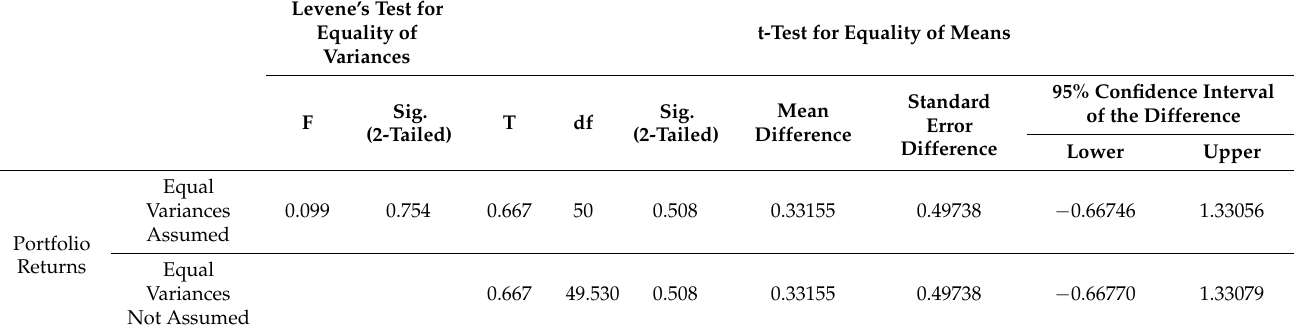
Table 7. Independent samples test for contrarian and value portfolio returns for year t + 4.